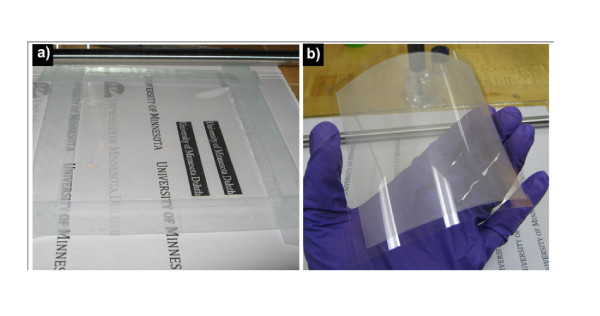
Pictures of the coating apparatus and fabricated Ag NW thin film. (a) Wire-wound rod (Meyer rod)-coating apparatus for Ag NW thin film. A piece of PET film was stuck on glass board with scotch tape before roll coating. (b) A large, uniform, and flexed Ag NW film on PET substrate with dimension of about 80 mm × 100 mm.